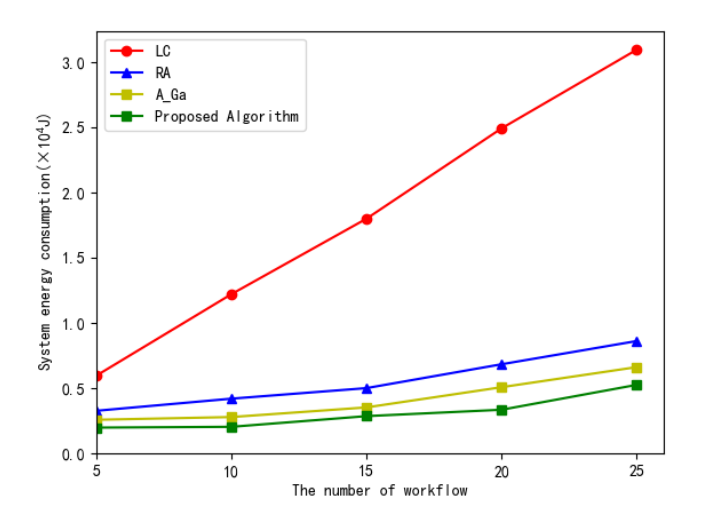
Figure 10. The total system energy consumption versus the number of workflow.